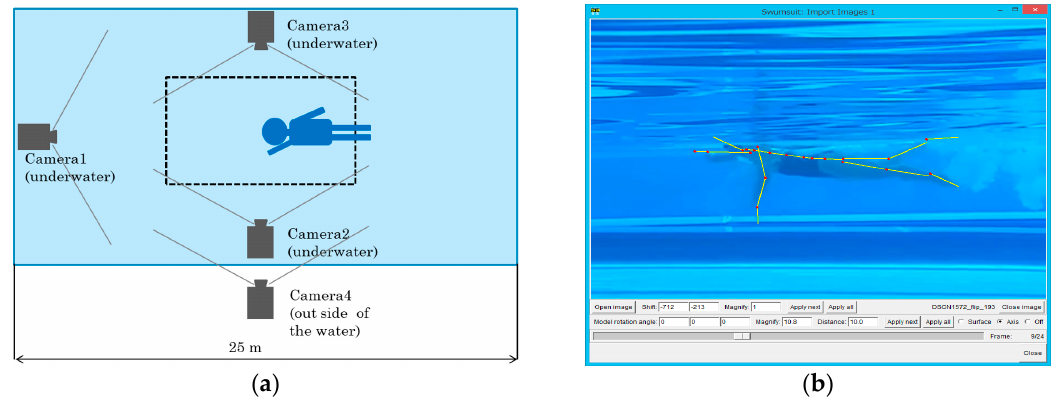
Figure 1. Experimental setup and screenshot of analysis software. ( a ) Experimental setup to film the swimming motion of the participant; ( b ) Screenshot of analysis software “Swumsuit” to determine the joint